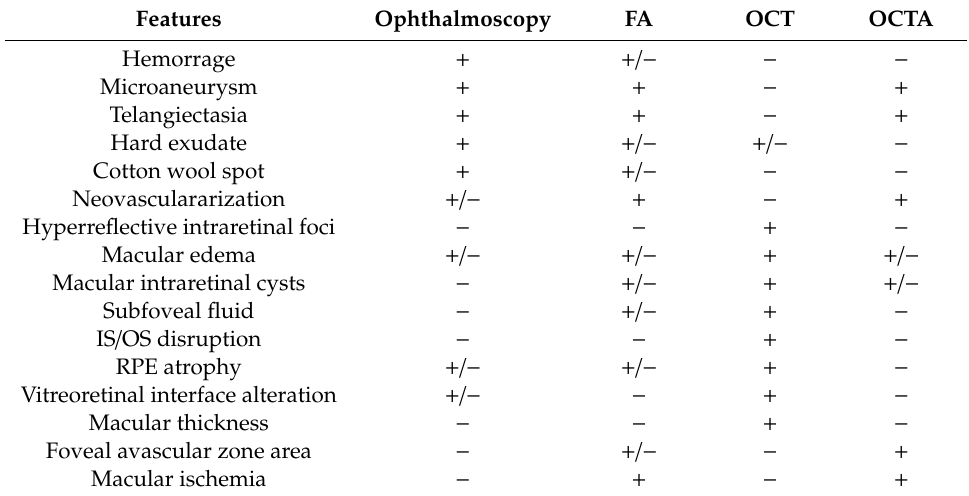
Table 2. Radiation maculopathy features detectable with multimodal